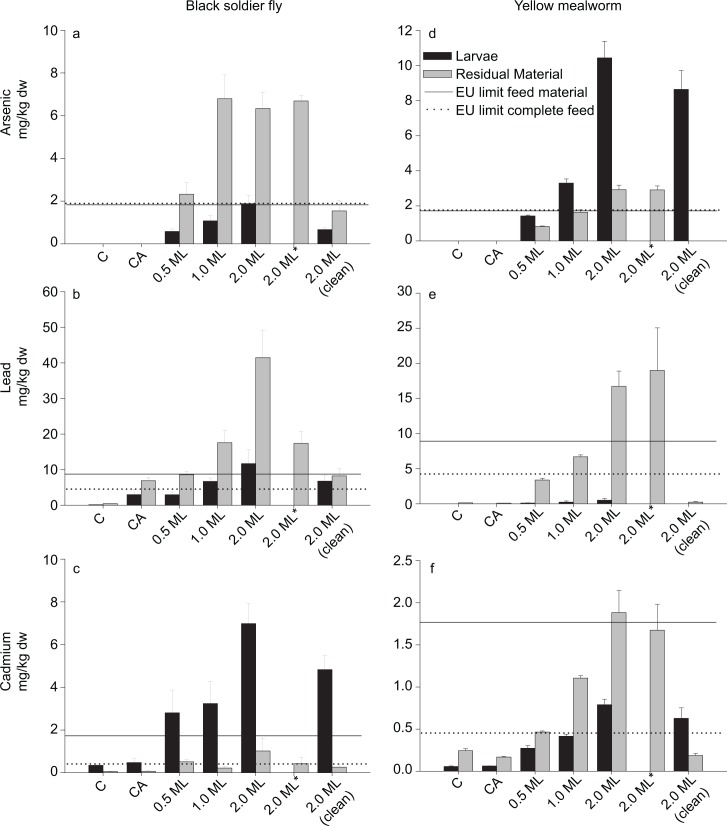
Concentrations of As, Pb and Cd in larvae (black bars) and residual material (grey bars) of the black soldier fly and the yellow mealworm (mean ± sd of three replicates).Provided with control feed (C), control feed with acid (CA), or feed containing 0.5,1.0 or 2.0 the EC maximum limit (ML). 2.0ML*: concentration in the residual material after transferring larvae to a clean container. 2.0ML (clean): concentrations after 2 days with original (clean) feed. The EC concentration limits of arsenic, lead and cadmium in feed materials (—) and in complete feed (…) (Directive 2002/32/EC). Full data are presented in S1 Table.